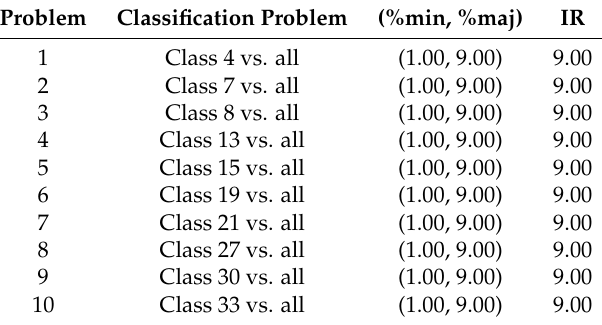
Table 15. The OvA configuration for the dataset in